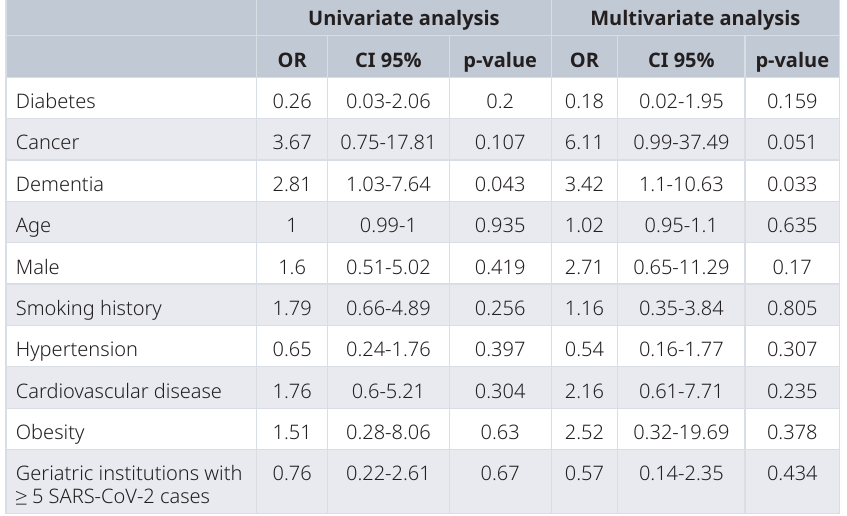
Table 2. Potential determinants of COVID-19 severe disease.